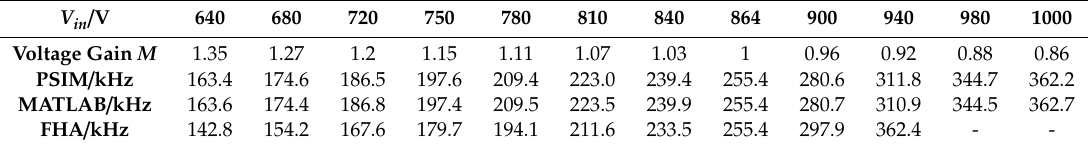
Figure 17. The voltage gains curves of LLC converter with different Q values. Table 2. Comparisons of switching frequencies of LLC converter at Q 2 = 0.2441.